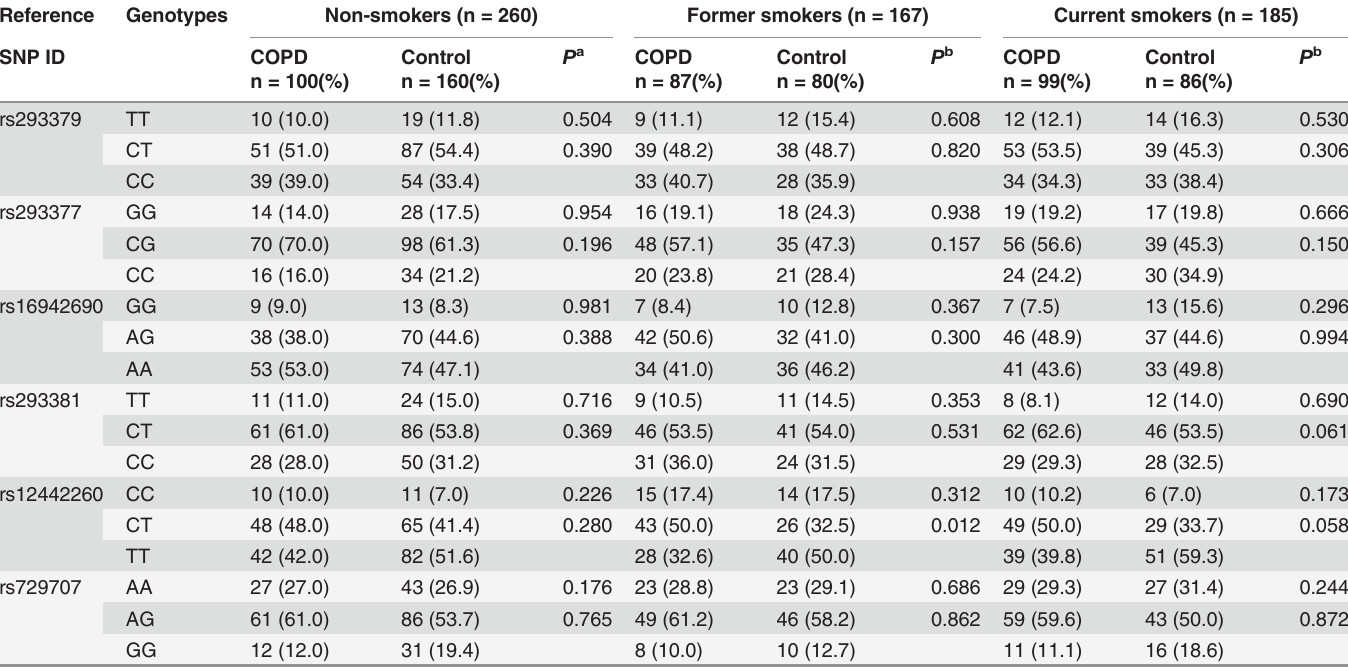
Table 3. Association between SNPs in the ABHD2 and COPD by smoking status-stratified analysis. Reference